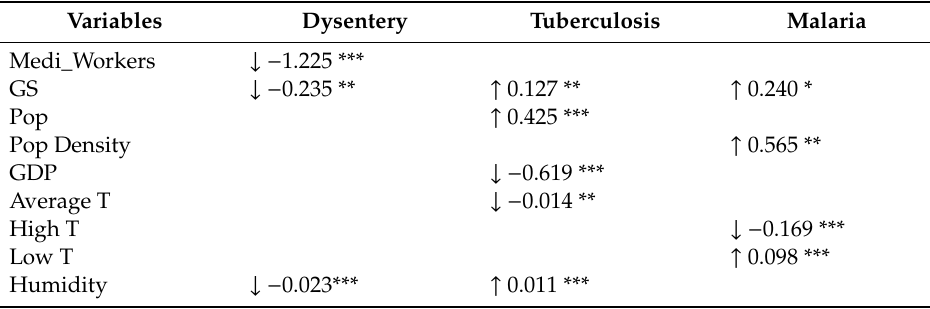
Table 8. Coe ffi cients of Panne Data Model with Stepwise Regression